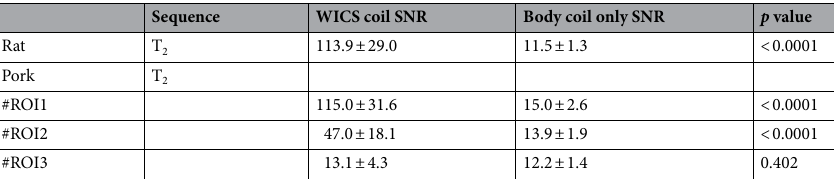
Table 1. Mean and standard deviations for SNR estimation in the ex vivo pork ( n = 7) and rat ( n = 5) experiments and two-sample t -test analysis between SNR values with and without WICS coil (body coil only).